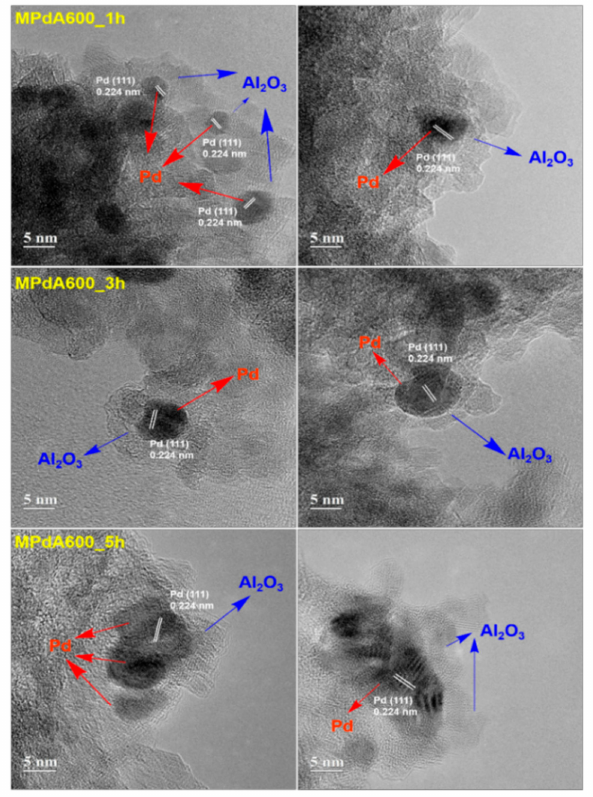
Figure 13. HRTEM images of MPdA catalysts calcined at 600 ◦ C for di ff erent periods of time: left images show fresh samples and right images show spent